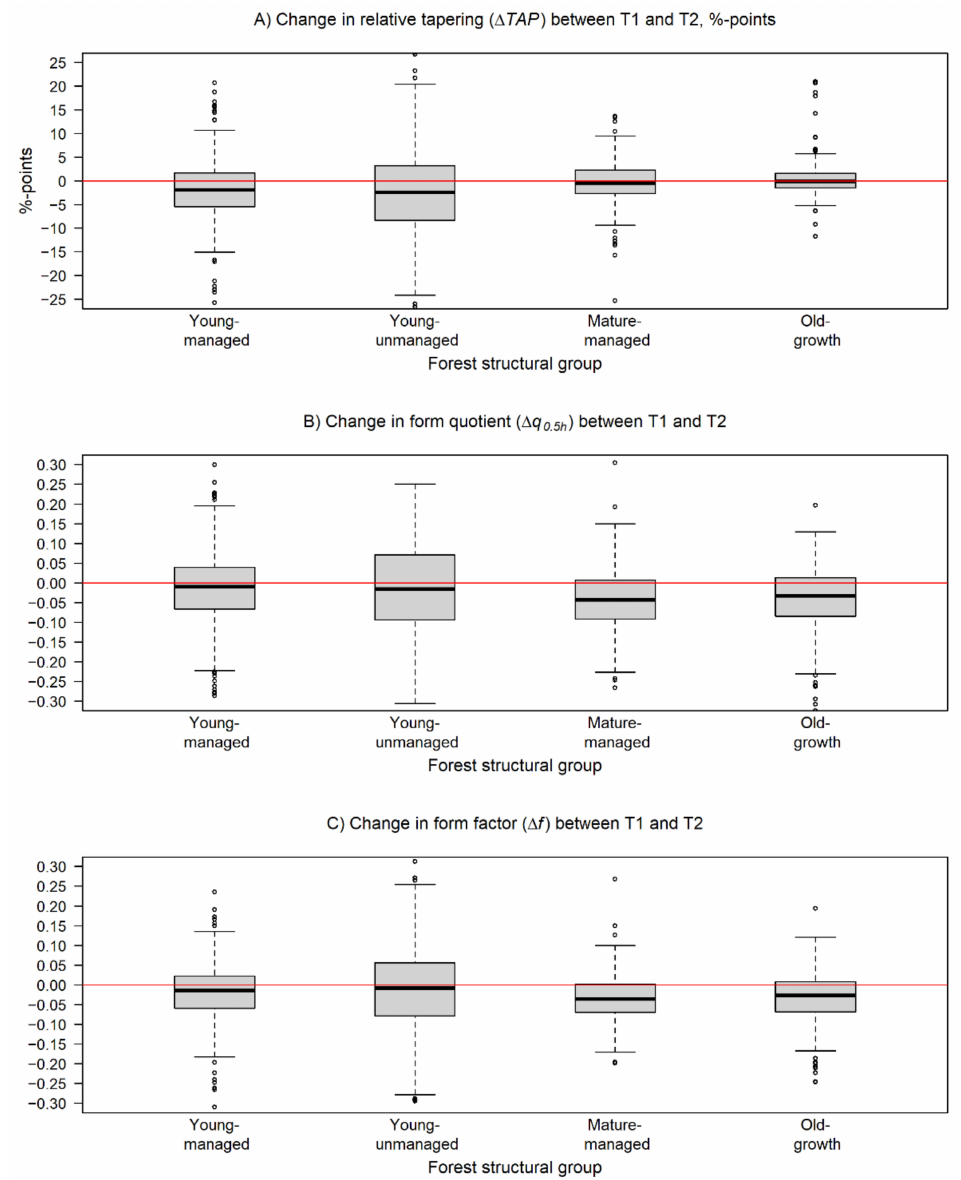
Figure 3. Box and whiskers plots describing the variation in the changes of the estimated ( A ) relative stem tapering ( ∆ TAP ), ( B ) normal form quotient ( ∆ q 0.5h ), and ( C ) cylindrical form factor ( ∆ f ) during the monitoring period within the forest structural groups. The black line represents the median of the change, and the box borders show the lower and upper quartile of the variation. The whiskers are used to indicate 1.5 times the interquartile range from the upper and lower quartiles. The changes in TAP are presented in percentage points while changes in q 0.5h and f are presented in absolute units. The horizontal red line is equal to no